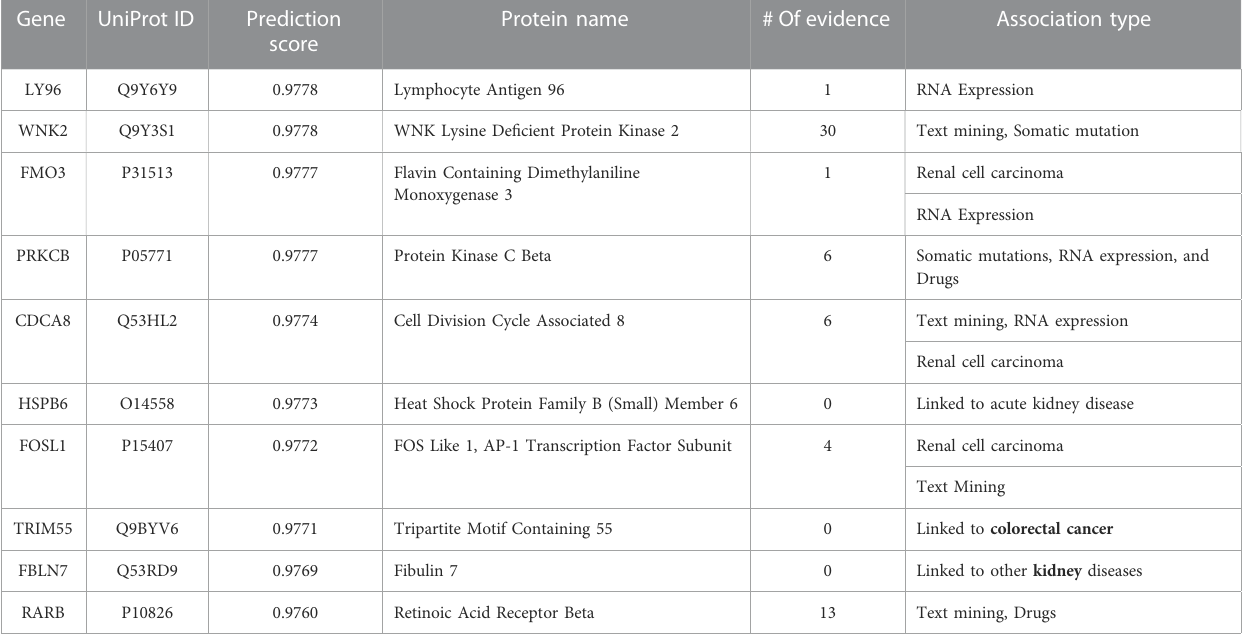
TABLE 7 Top 10-ranked novel predicted therapeutic targets basedon the prediction score for kidney cancer with the number and type of evidence linking the targets and disease. Gene UniProt